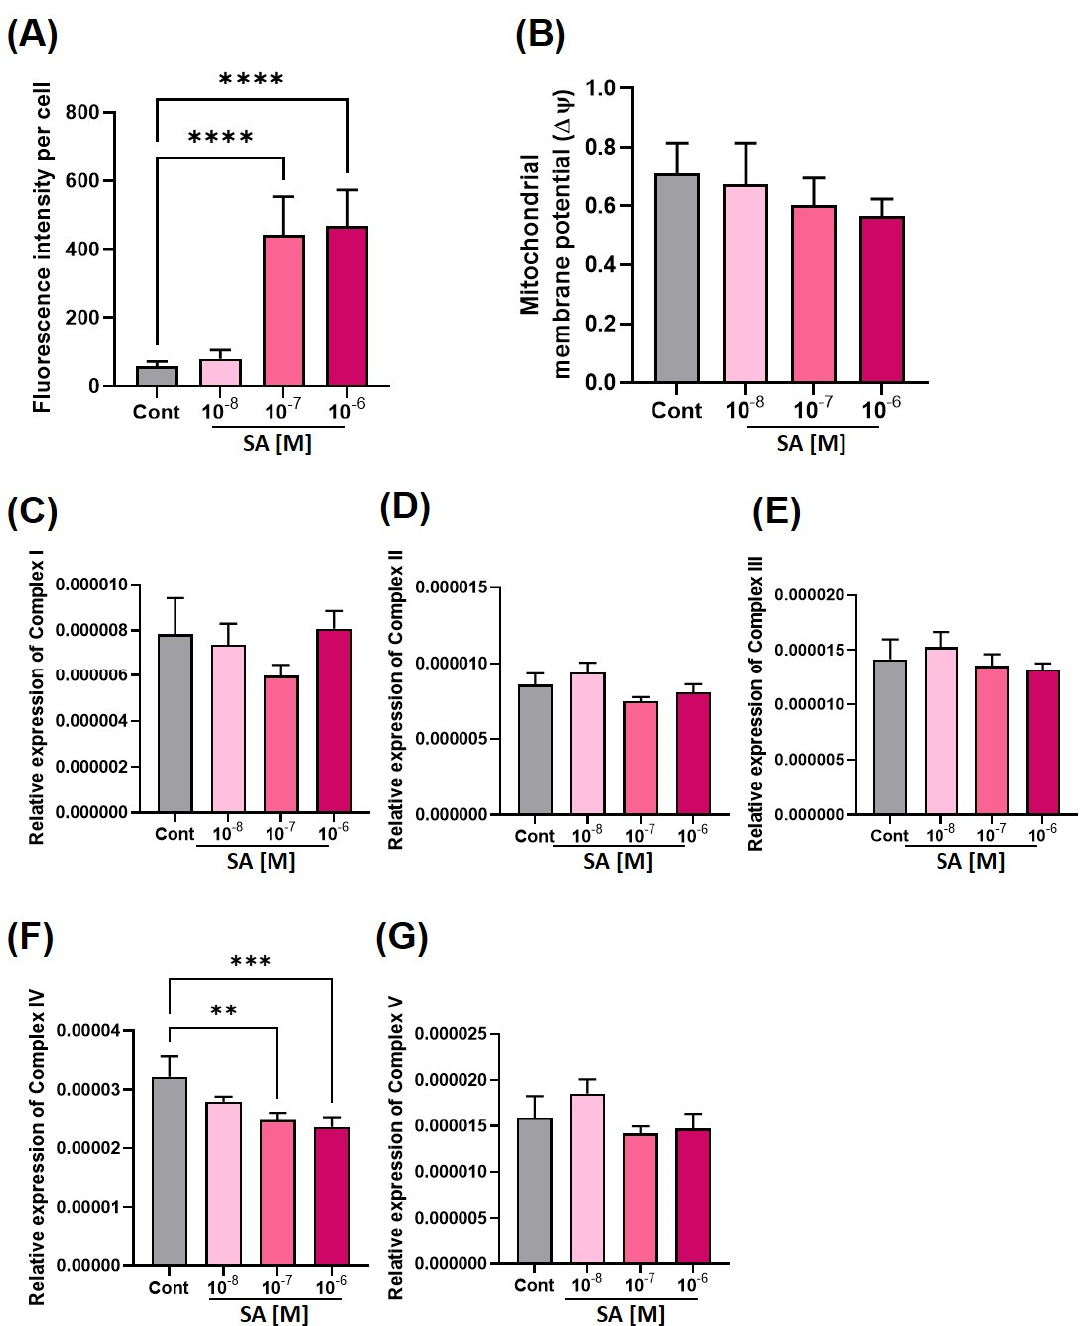
Figure 3. Change in the mitochondrial function and mitochondria-related gene expression in EB. The mitochondrial dysfunction during SA exposure in the EB state for four days was measured. ( A ) Bar graph of mitochondrial superoxide using mitoSOX staining, and ( B ) Bar graph of the mitochondrial membrane potential by Jc-1 staining. ( C – G ) Bar graphs show the gene expression levels of ( C ) Complex I, ( D ) Complex II, ( E ) Complex III, ( F ) Complex IV, ( G ) Complex V. The significance was obtained by ANOVA test. ** p < 0.01, *** p < 0.005 and **** p < 0.0001 vs. control. Each value is expressed as the means ± SD. n = 6 ( A , B ) n = 3 ( C – G ) in three independent experiments. Cont; control, SA; sodium